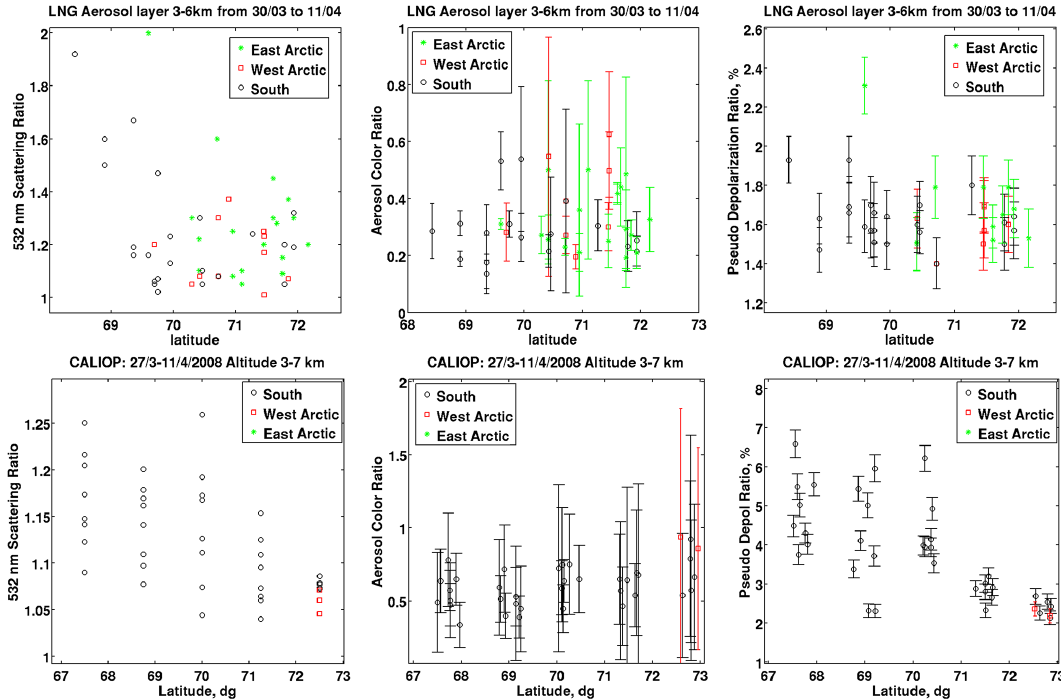
Figure 10. Latitudinal distribution of 532nm backscatter ratio (left), aerosol colour ratio (middle) and pseudo-depolarization ratio (right) for the airborne lidar observations (top) and filtered level 1 CALIOP (bottom) at altitudes between 3 and 7km during the aircraft campaign. The colours are for different air mass origins estimated with FLEXPART (see